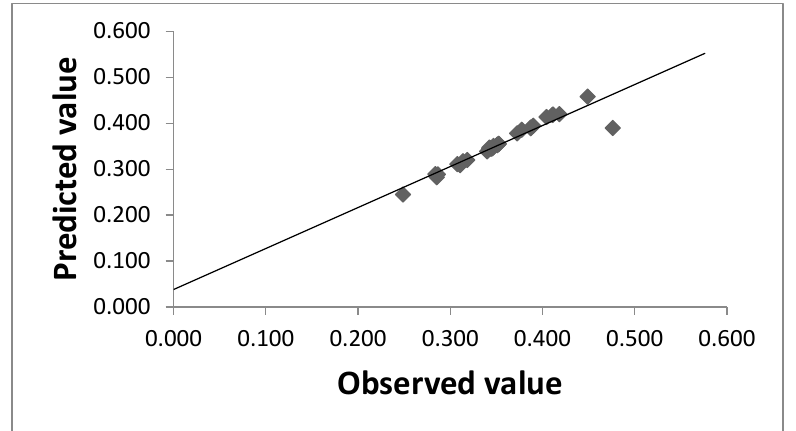
Figure 2. Biovanillin production graph comparing observed and predicted values.